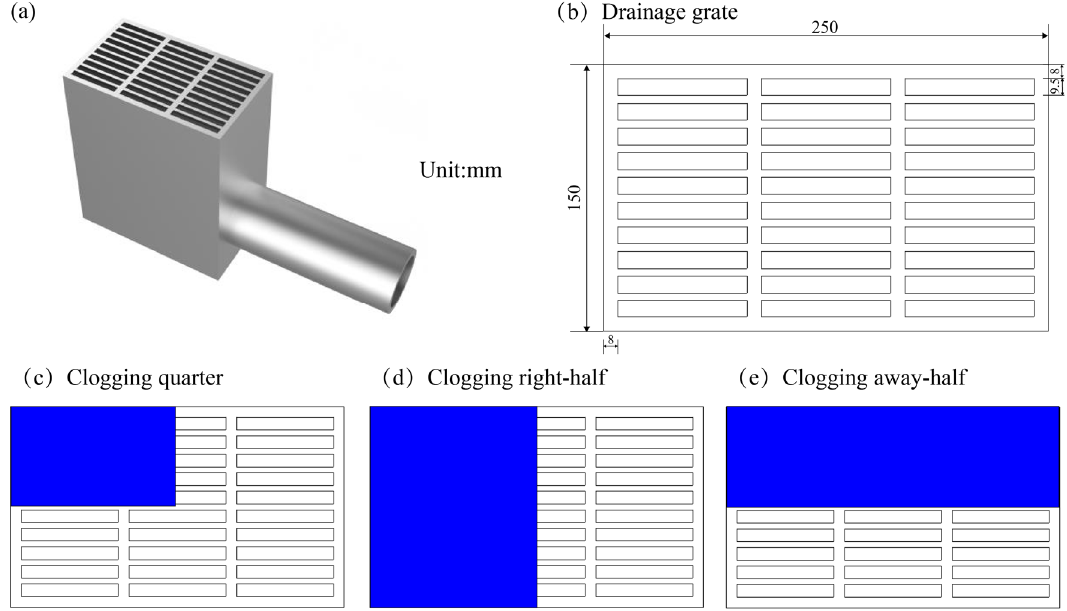
Figure 2. Inlet structure under different clogging conditions . Table 2. Incoming critical state water depth under different clogging conditions.